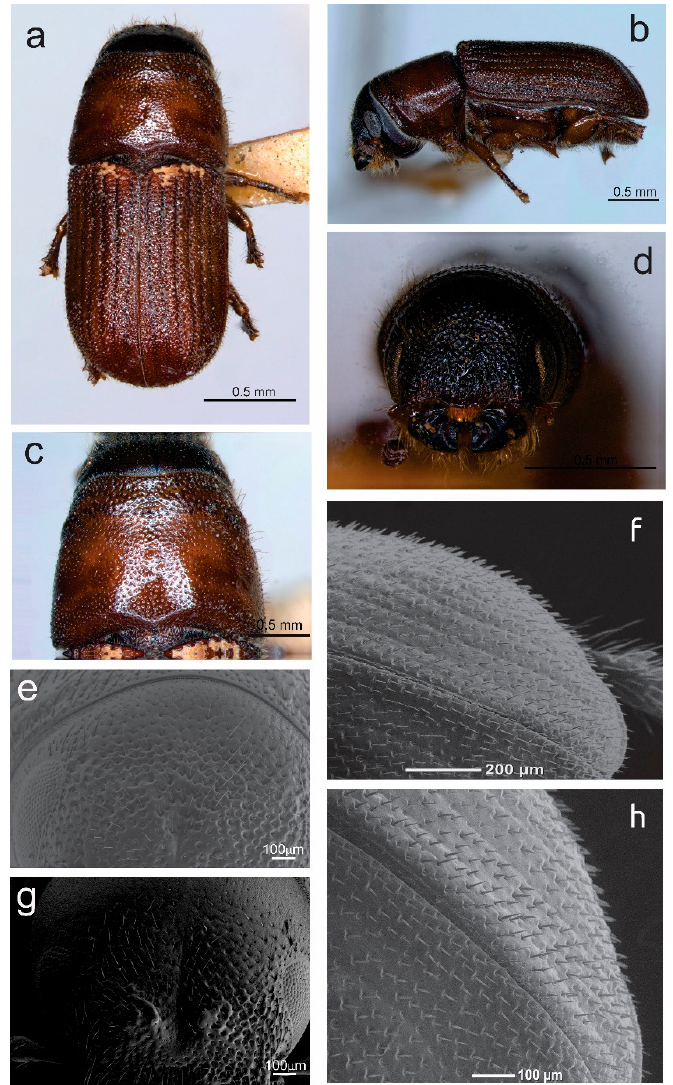
Figure 9. Dendroctonus barberi : ( a ) Female in dorsal view, ( b ) female in lateral view, ( c ) female pronotum, ( d ) frons sculpture of female, ( e ) female frons, ( f ) elytral declivity, ( g ) frons sculpture of male, ( h ) elytra in dorsal view. Photos a – d (from type specimens of D. barberi ).